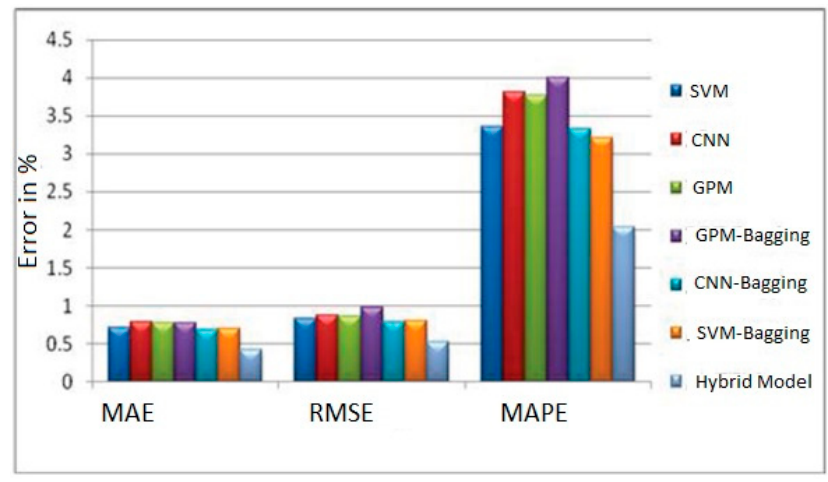
Figure 14. Performance of the various classi fi ers with the proposed model.